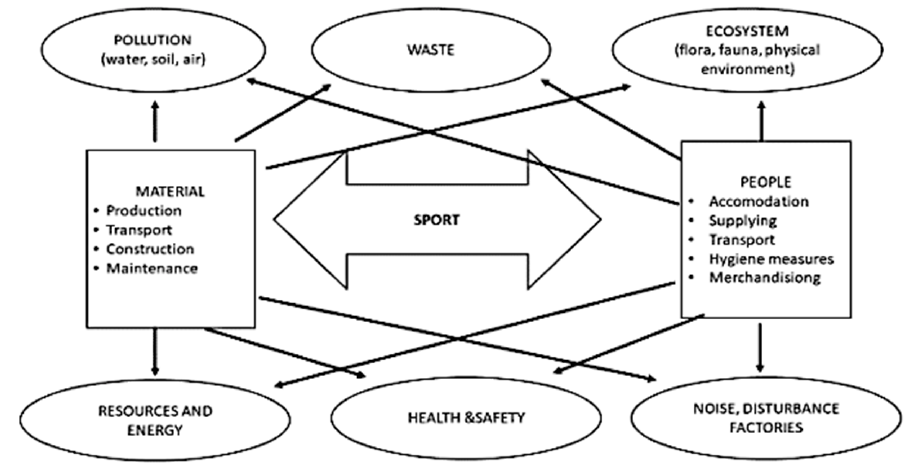
Figure 1. Systematic analysis of the carbon footprint in sport [39].